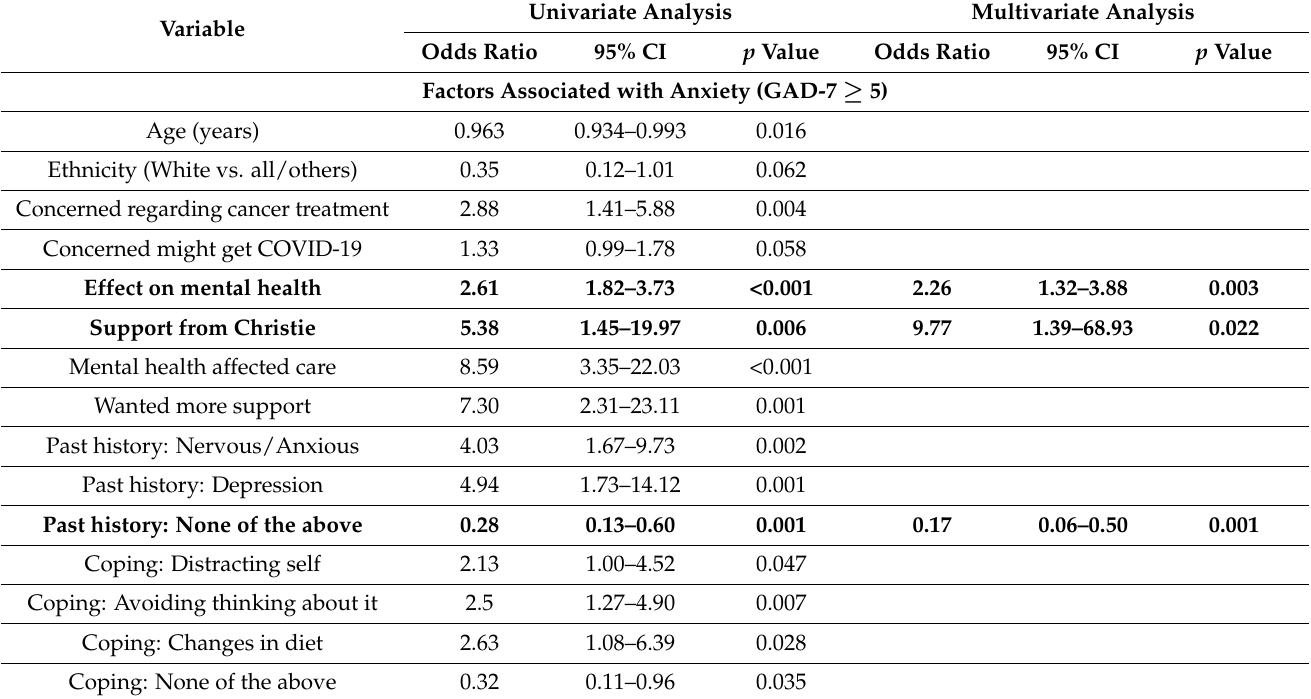
Table 3. Univariate and multivariate analyses of factors associated with anxiety (GAD-7 ≥ 5), de-